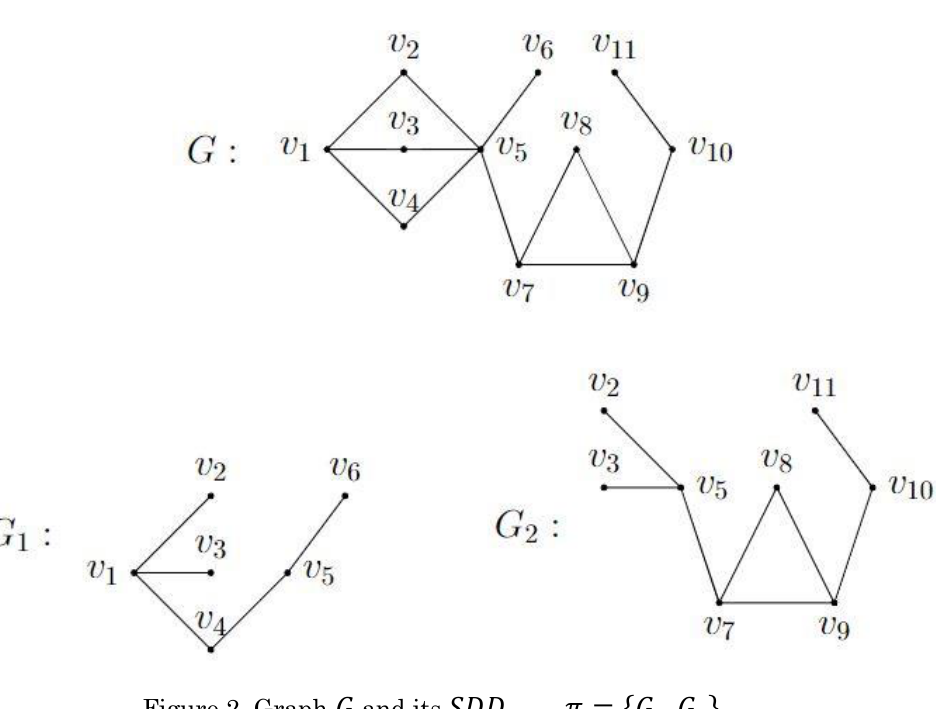
Figure 2. Graph 𝐺 and its 𝑆𝐷𝐷 𝑚𝑎𝑥 , 𝜋 = {𝐺 1 , 𝐺 2